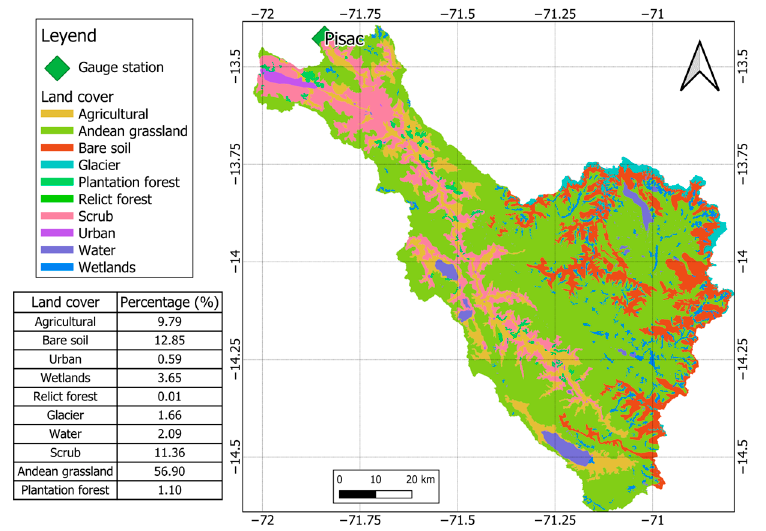
Figure 2. The land cover/use map of the VUB region is derived from the National Ecosystem Map Data [19].